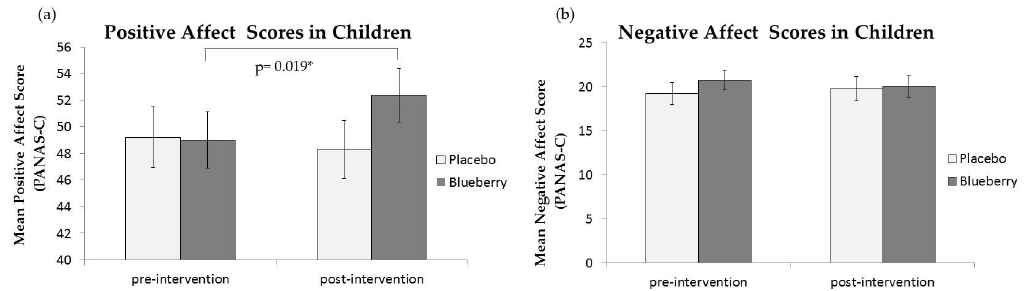
Figure 2. Mean PANAS-C scores in children aged 7–10 years: ( a ) Mean PA scores pre- and post-consumption of placebo and WBB drinks; ( b ) Mean NA scores pre- and post-consumption of placebo and WBB drinks. * Significant at <0.05. Attained from post-hoc paired samples t ‐ test.